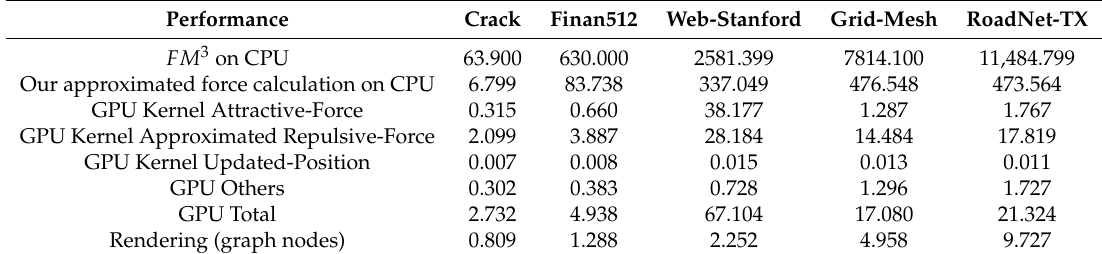
Table 2. Performance results (milliseconds per iteration) on each tested